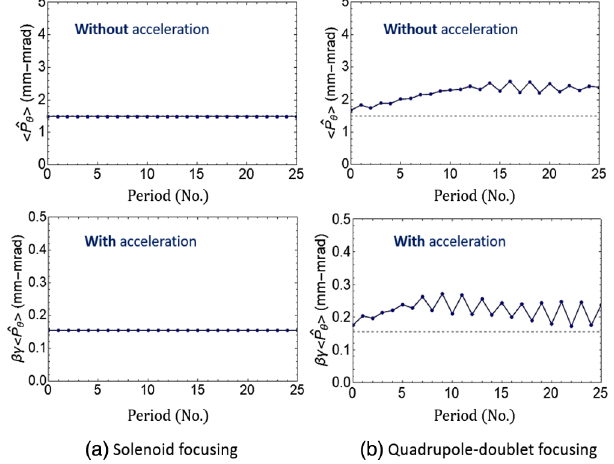
ˆ P beams.FIG. 3. The plots of h θ i change without acceleration (upper ˆ P plots) and βγ h θ i change as the beam is accelerated from β ¼ 0 . 1028 to β ¼ 0 . 17 (lower plots) along (a) the solenoid focusing channel and (b) the quadrupole-doublet focusing chan- ˆ P βγ h ˆ P nel. Whereas h θ i and θ i are conserved in solenoid lattices, they are not conserved in quadrupole lattices. The initial trans- verse tune depression is σ ⊥ = σ ⊥ 0 ¼ 0 . 78 and 0.7 for the beams without and with acceleration,